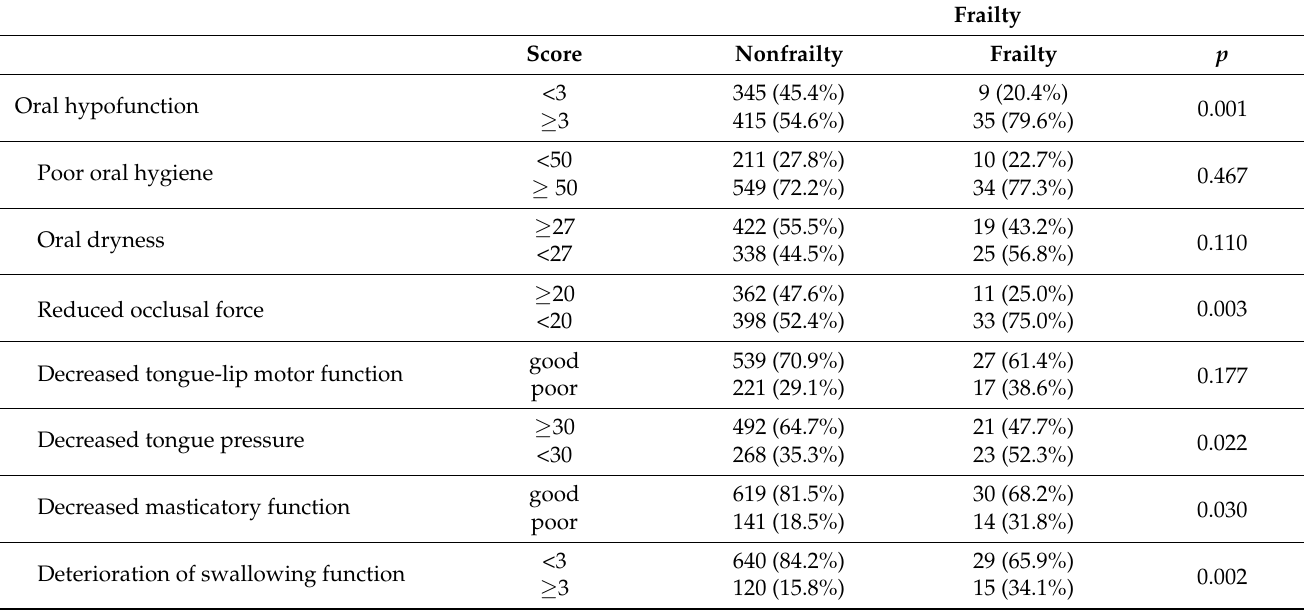
Table 2. Association of Oral Hypofunction with Frailty, Sarcopenia, and Mild Cognitive Impairment. Frailty Score